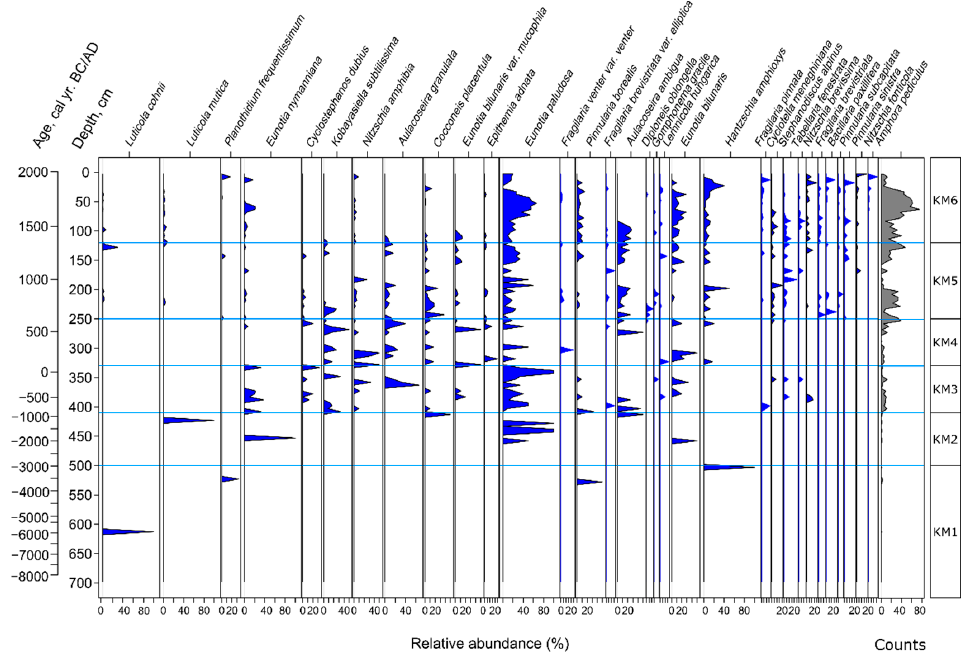
Figure 9. Composition of diatom assemblages in the deposits of the Krivetskiy Mokh mire (only species observed in five or more samples with the maximum relative abundance at least 3% are shown). Blue color—relative abundance of taxa, grey color—total counts. KM1–KM6—the zones defined based on the main developmental stages of the mire.